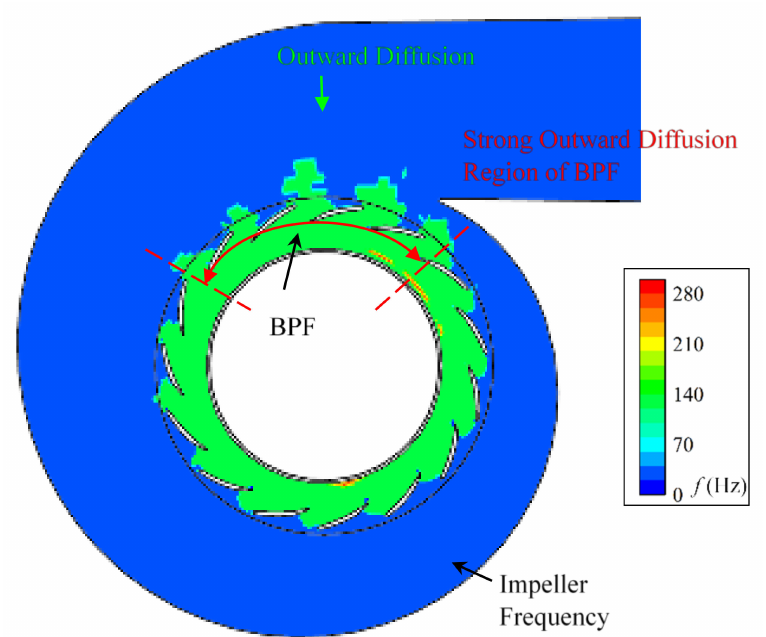
Figure 13. Main frequency distribution on Z = 0 plane.